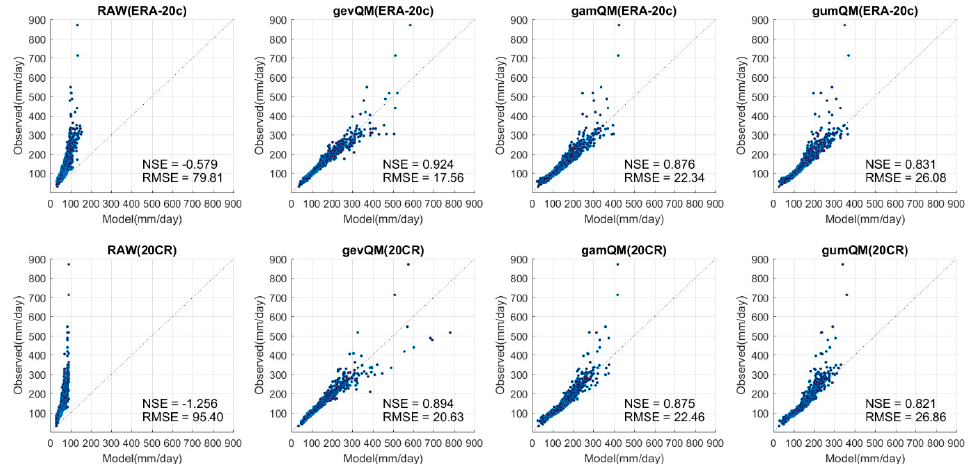
Figure 3. Scatter plots between the annual maximum rainfalls (AMRs) of the observation and the model data (the raw reanalyses (RAW(ERA ‐ 20c) and RAW (20CR)) and the bias ‐ corrected reanalyses (i.e., ERA ‐ 20c and 20CR) by the quantile mapping (QM) approaches with generalized extreme value (GEV), gamma and Gumbel distributions (gevQM, gamQM and gumQM)) over 48 stations, from 1974 to 2010. Table 2. Error estimation results of RMSE (mm) and NSE for the uncorrected (RAW) ERA ‐ 20c and 20CR, and the bias ‐ corrected reanalyses (i.e., ERA ‐ 20c and 20CR) by the QM approaches with GEV, gamma and Gumbel distributions (gevQM, gamQM and gumQM) over 48 stations from 1974 to 2010.